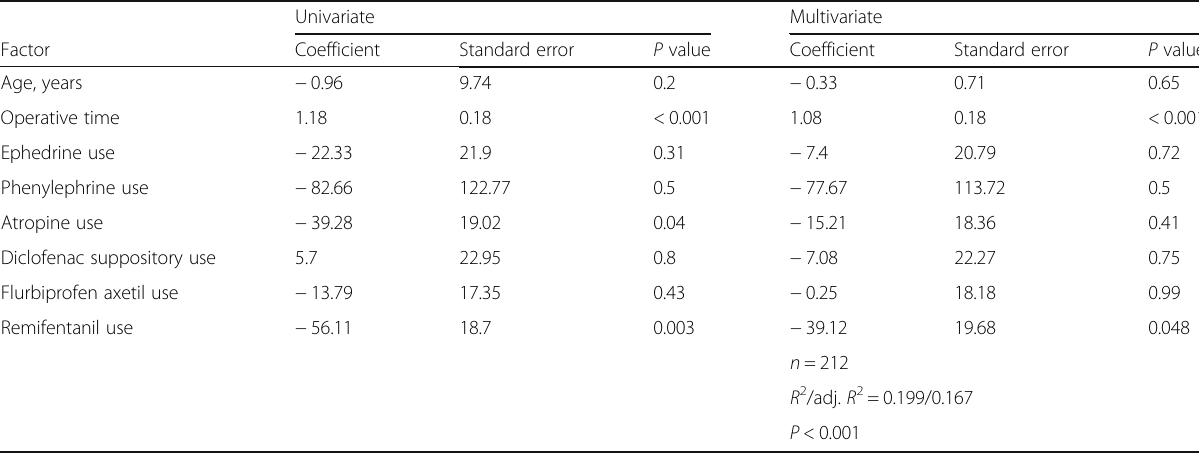
Table 4 Univariate and multivariate linear regression analyses to identify the factors associated with blood loss during